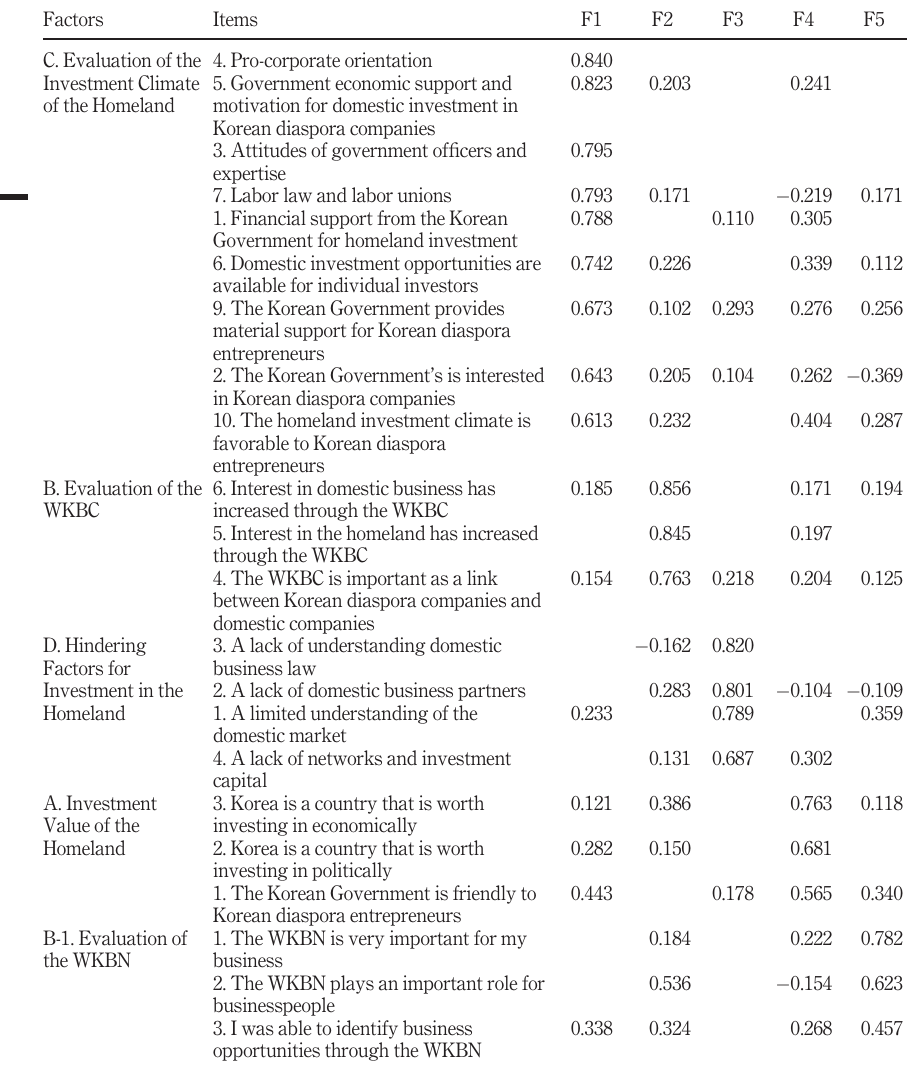
Table VIII. Results of the factor